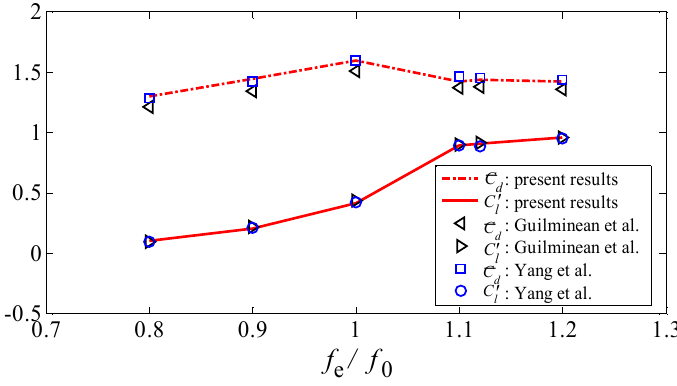
Figure 8. Mean drag coefficient C d and RMS of lift coefficient C (cid:48) for flow past a transversely oscillating cylinder at different (cid:1858) (cid:3032) /(cid:1858) (cid:2868) .